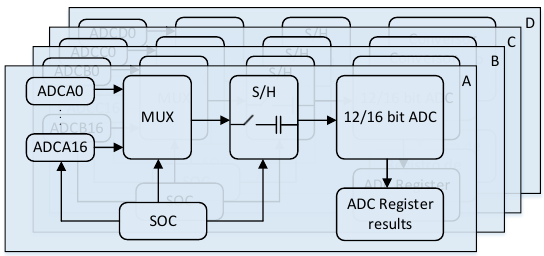
Figure 5. ADC Operation Diagram.